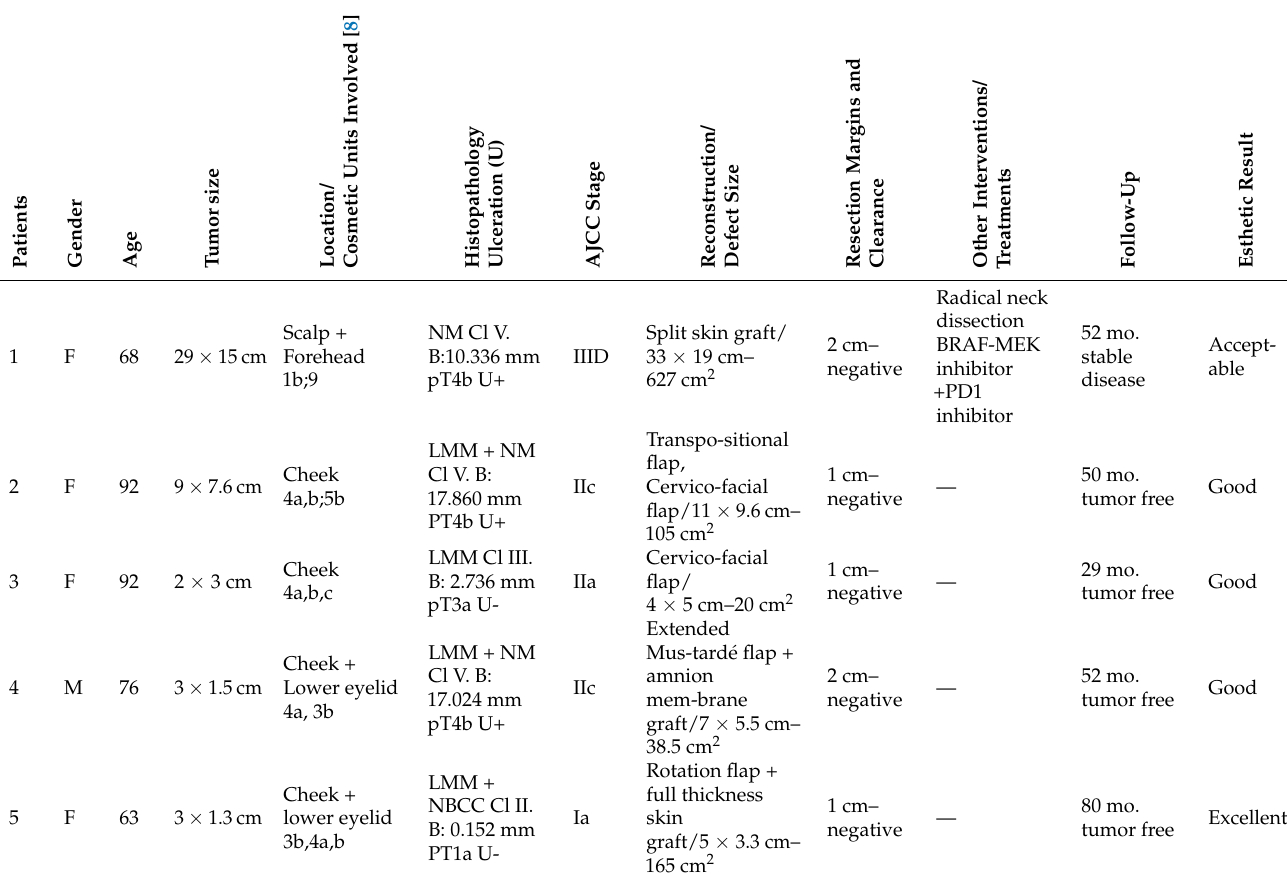
Table 1. Data summary of included